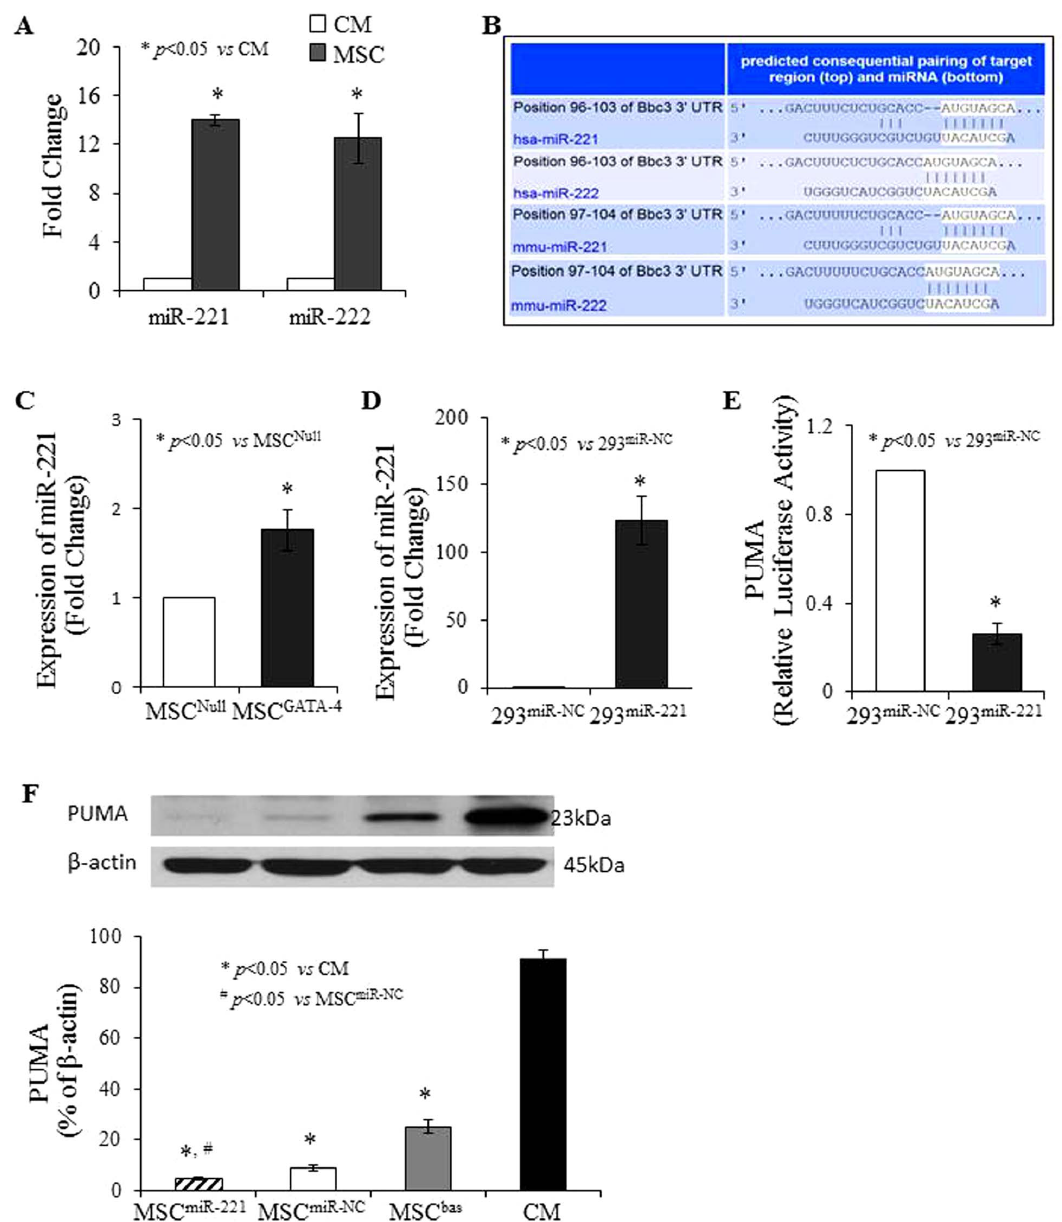
Figure 3. Expression of miR-221/222 and PUMA in MSC and CM. Panel A: miR-221/222 expression in MSC and CM assayed using real-time PCR. Panel B: TargetScan shows the 3 9 UTR of PUMA containing the conserved miR-221/222 binding site. Panel C: miR-221 expression in MSC GATA-4 and MSC Null . Panel D: miR-221 expression in 293 miR-221 and 293 miR-NC . Panel E: PUMA in 293 miR-221 and 293 miR-NC , respectively. Panel F: Western blot of PUMA and corresponding semi-quantitative data in different cells. 293 miR-NC =293TN transfected with lenti-miR-NC; 293 miR-221 =293TN transfected with lenti-miR-221; MSC bas = basal MSC; MSC miR-221 =MSC transfected with miR-221; MSC miR-NC =MSC transfected with miR-NC. doi:10.1371/journal.pone.0073304.g003 MSC (green arrow) and in GFP negative cells (red arrow) (Figure 6A).